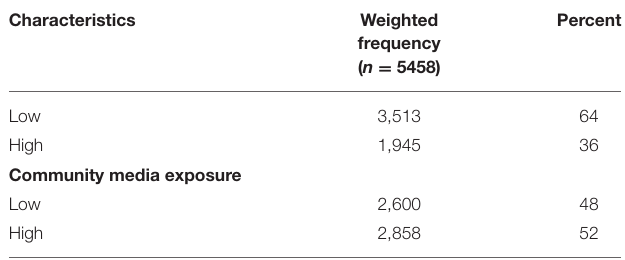
TABLE 2 | Socio demographic characteristics of women’s and husbands/partners.